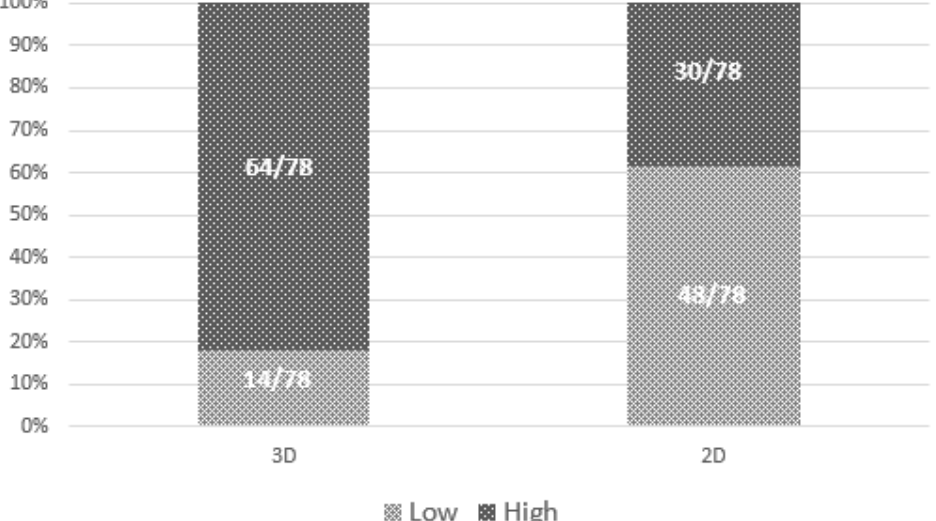
Figure 5. Distribution of high versus low conspicuity. Bar graphs demonstrate the conspicuity distribution of lesions (low conspicuity or high conspicuity), comparing digital breast tomosynthesis (DBT) or synthesized 2D mammograms (synt2D).